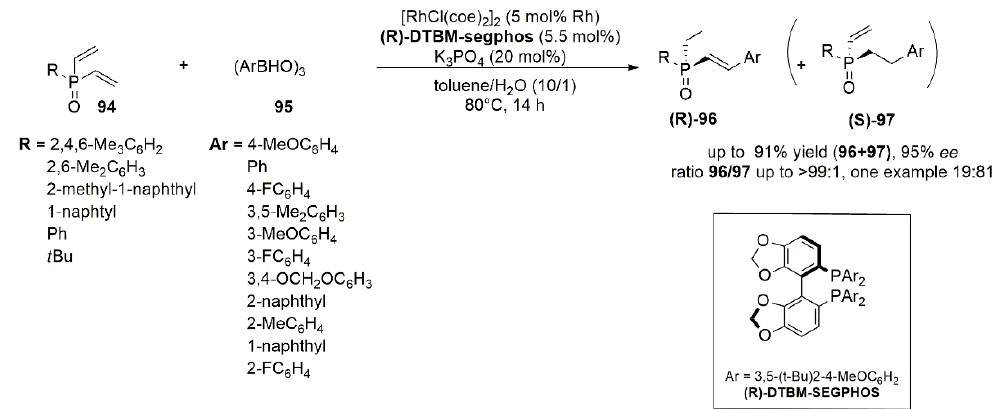
Figure 39 . Asymmetric hydroarylation of divinylphosphine oxides ( 94 ) and aryl boroxines ( 95 ). Catalyst complex: Rh/(R)-DTBM-segphos.